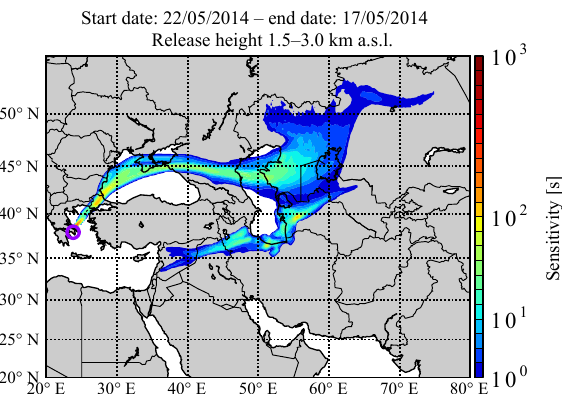
Figure 9. FLEXPART footprint for the air mass traveling below 2km height and arriving over Athens between 1.5 and 3.0kma . s . l . at 20:28–21:28UTC on 22 May 2014. The colors represent the log- arithm of the integrated residence time in a grid box in seconds for a 6-day integration time.